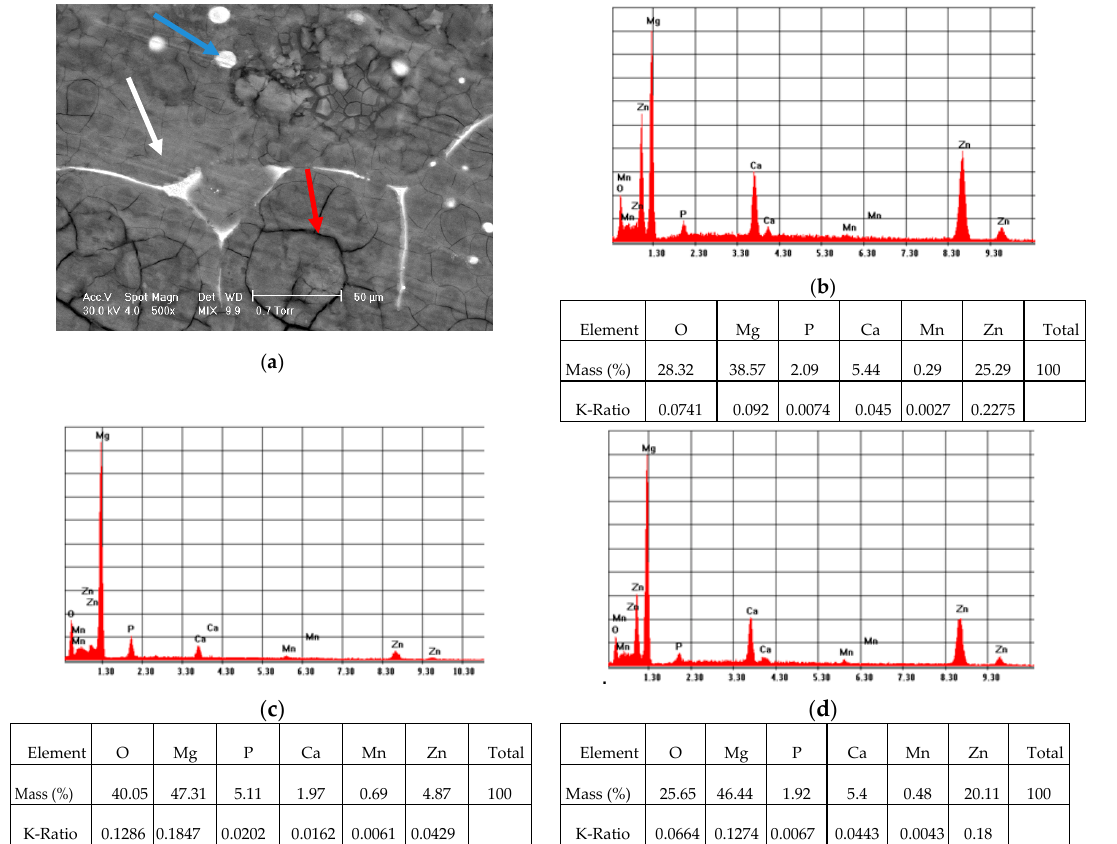
Figure 4. SEM images (magnification 500×) of the coated ZMX410 sample ( a ) and corresponding Energy-Dispersive Spectroscopy (EDS) spectrum: ( b ) globular particles (blue arrow); ( c ) surface (white arrow); ( d ) compounds at the grain boundary (red arrow).